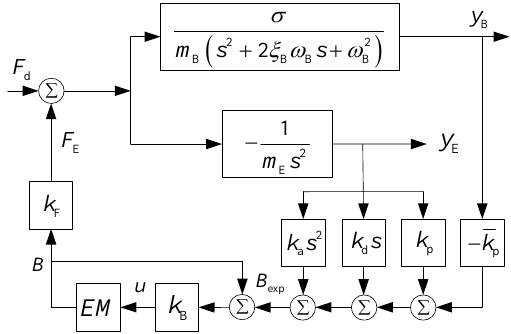
Figure 2. The equivalent block diagram of maglev vehicle-bridge system.